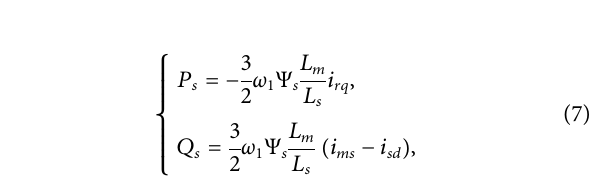
FIGURE 3 | dq-axis spatial